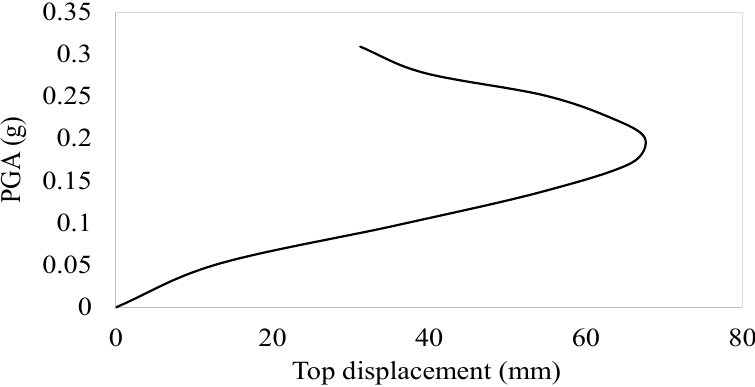
Figure 3. Mean out-of-plane IDA curve of the unretrofitted facade of the building. As shown in Figure 3, the maximum out-of-plane displacement of the top of the facade wall is 68 mm for a seismic intensity of 0.2 g. The energy performance of the